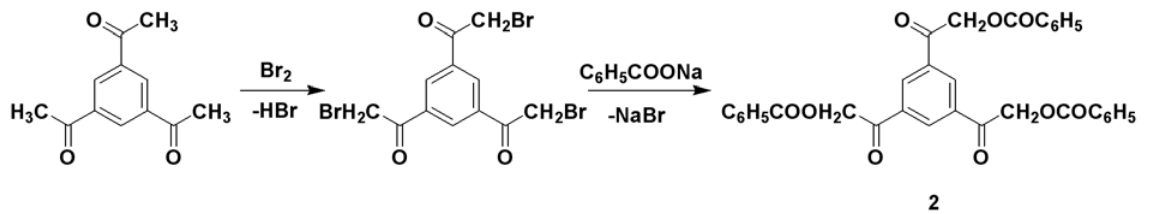
Scheme 5 Synthesis of compd 2 .